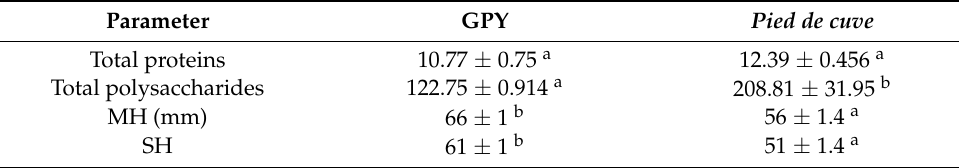
Table 2. Effect of the S. cerevisiae strain IOC 18-2007 inoculum preparation method on foaming properties: foamability (HM) and foam persistence (HS) (expressed as mm), and total polysaccharides and proteins (expressed as